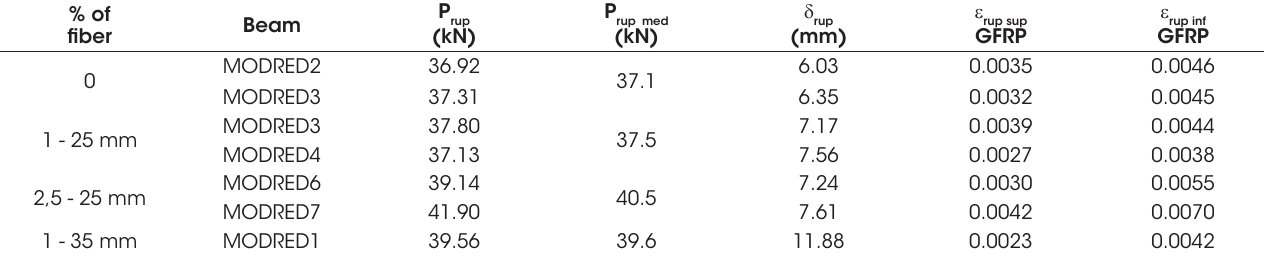
Hybrid beams test results